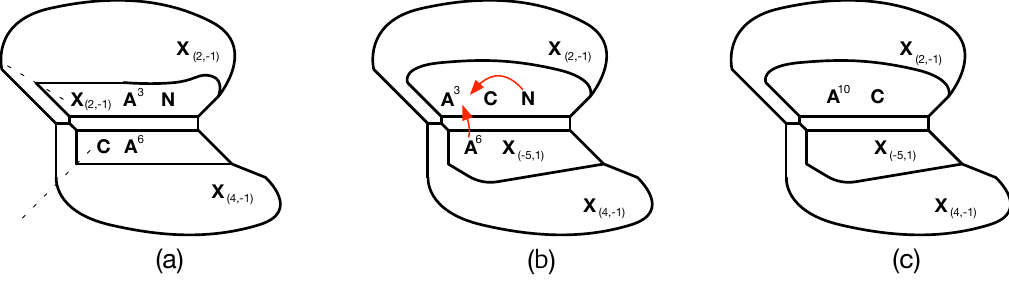
Figure 21 . (a) A 5-brane con(cid:12)guration for the SU(6) 0 + 1 diagram. As there are many 5-branes attached to the 7-branes which make 5-brane web complicated, here we give a sketch on how the 7-brane charges are altered. The number of 5-branes attached to a 7-brane can be read o(cid:11) by tracking the number of Hanany-Witten transitions taking place in (cid:12)gure (b).